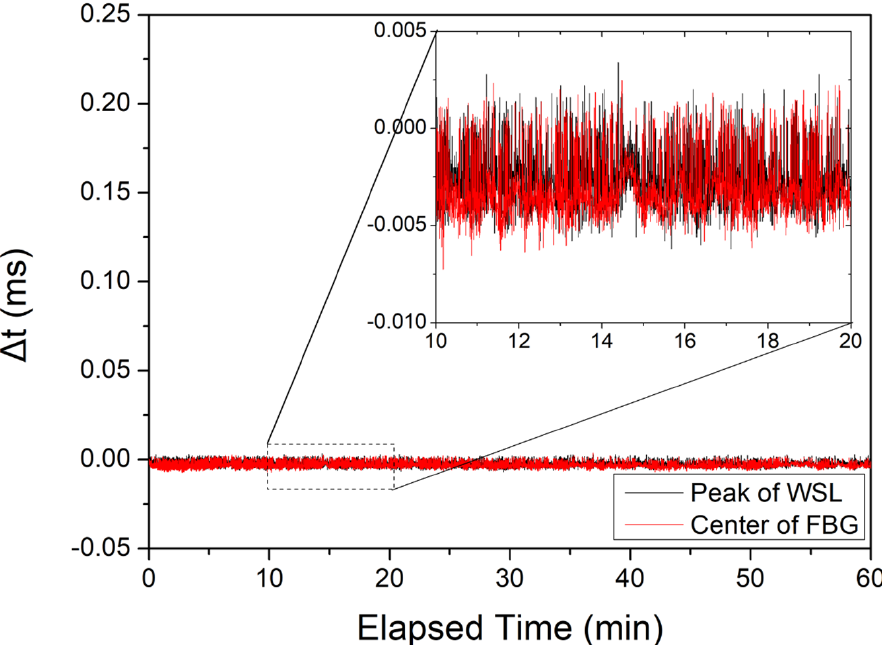
Figure 6. Range of peak position, ∆ t of WSL (red line) and FBG (black line) in the temporal domain when a WSL stabilization closed-loop control system is applied.